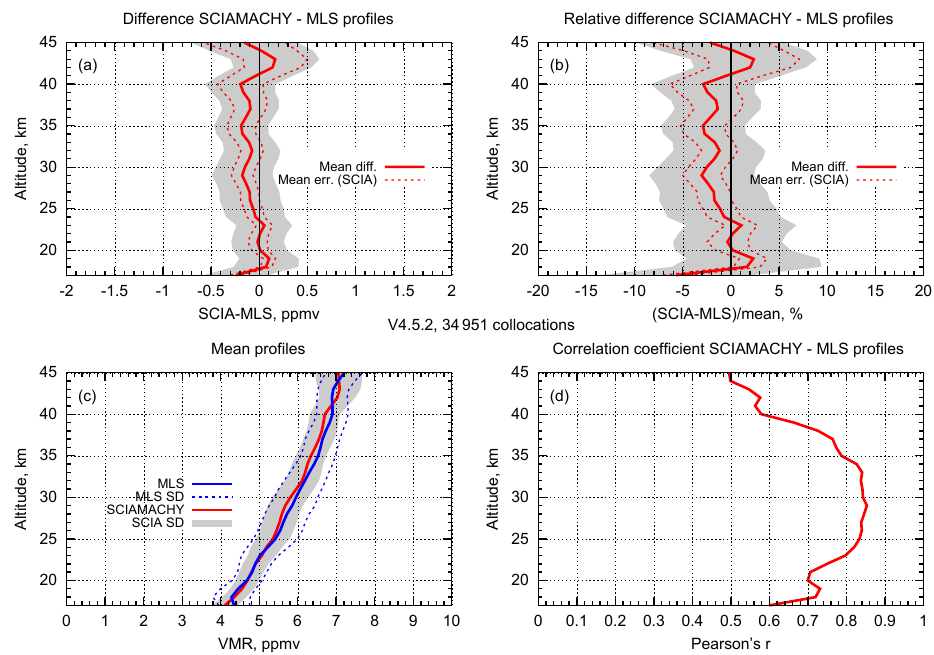
Figure 5. Same as Fig. 4, but for comparison of retrieved SCIAMACHY H 2 O profiles with MLS V4.2 data